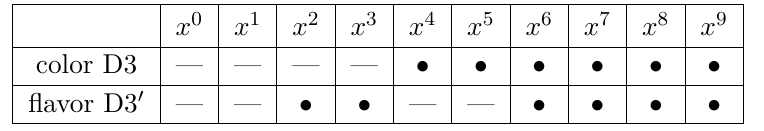
Table 1 . The supersymmetric D 3 /D 3 0 brane setup. In the above notation — stands for a brane which is extended along that particular direction, while • means that the coordinate is transverse to that